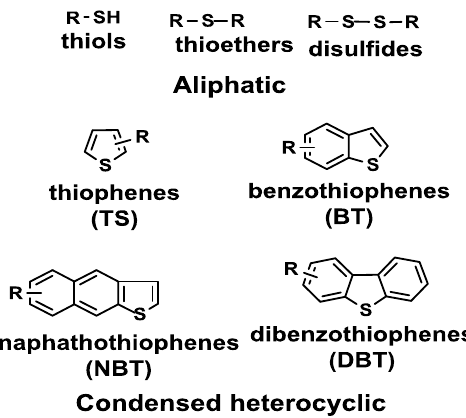
Figure 8. Main sulfur-containing compounds in petroleum fuels. Reproduced with permission [121].